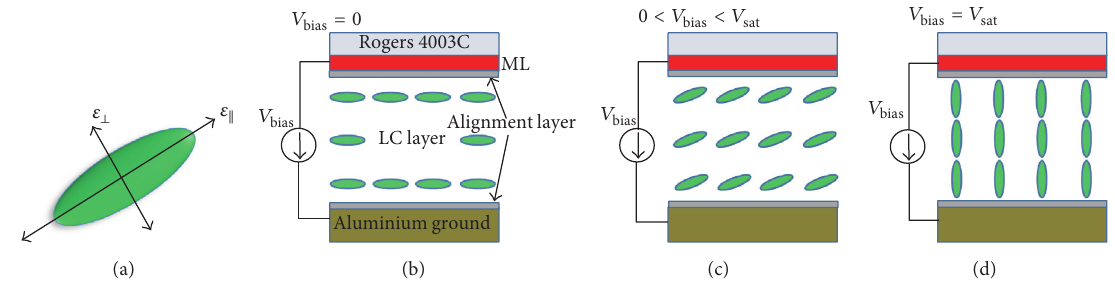
Figure2:(a)SingleLCmoleculeandstatesofLCmoleculesundervariousbiasedvoltages.(b) 𝑉 bias = 0 ,(c) 0 < 𝑉 bias < 𝑉 sat ,and(d) 𝑉 bias = 𝑉 sat .